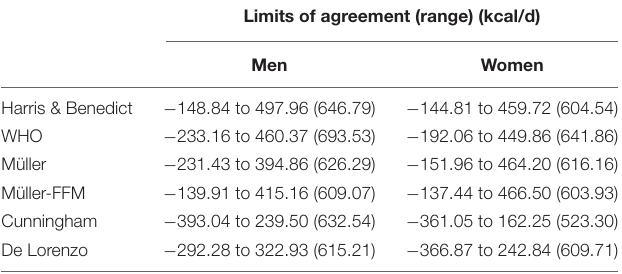
TABLE 2 | Limits of agreement.